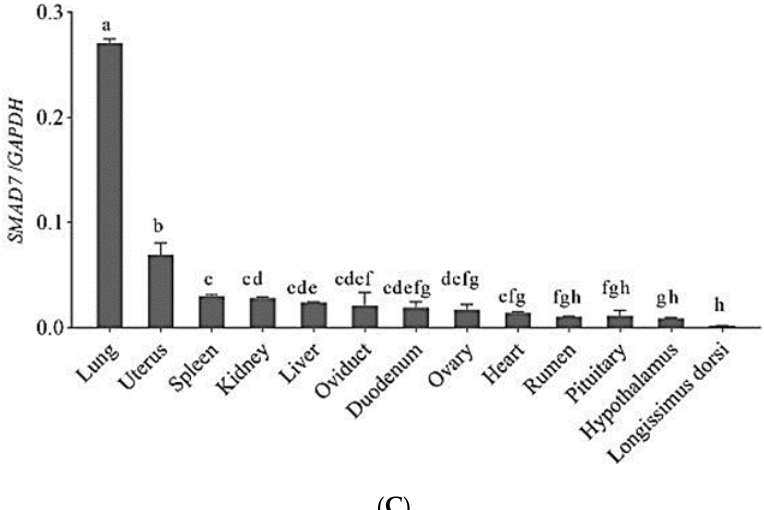
Figure 1. Expression of SMAD4 ( A ), SMAD5 ( B ) and SMAD7 ( C ) mRNAs in different tissues of Tibetan sheep. The expression of SMAD4 , SMAD5 and SMAD7 genes was detected by qPCR, and the GAPDH gene was used as the internal control gene . Each sample was repeated to determine in triplicate, and the data were collected as mean ± standard deviation. Note: different superscripts indicate significant difference ( p < 0.05).